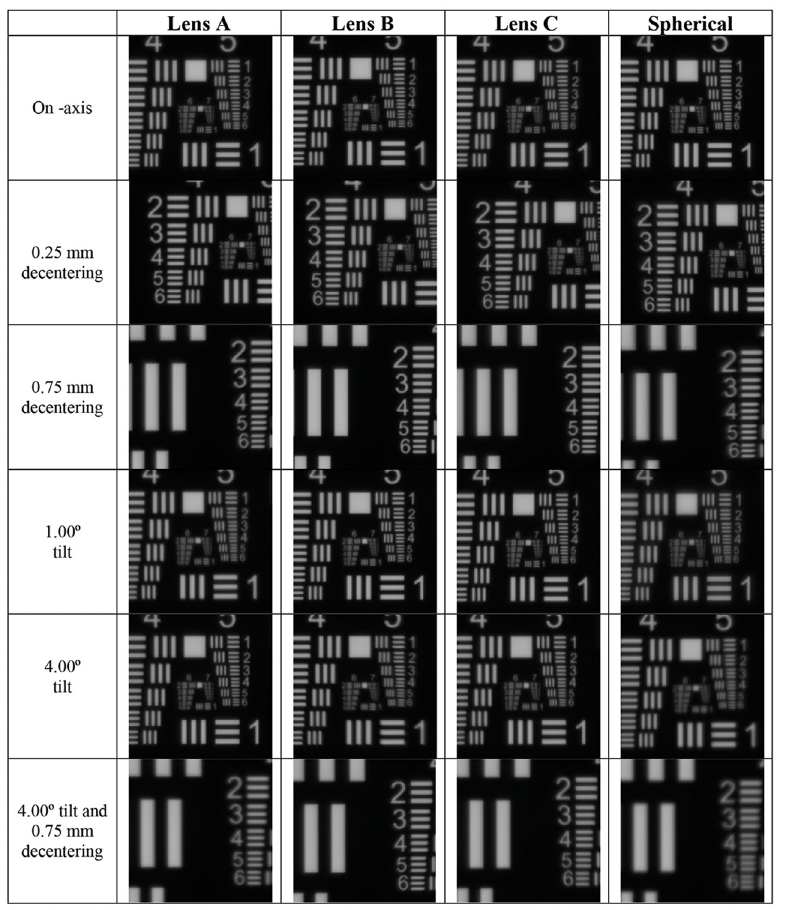
Fig 6. Experimental 1951 USAF test images for a refractive power of +20.00 D and for all the IOL designs. Images on-axis, for misalignments of 0.25 and 0.75 mm, tilts of 1˚ and 4˚ and a combination of 0.75 mm of misalignment and 4˚ of tilt are